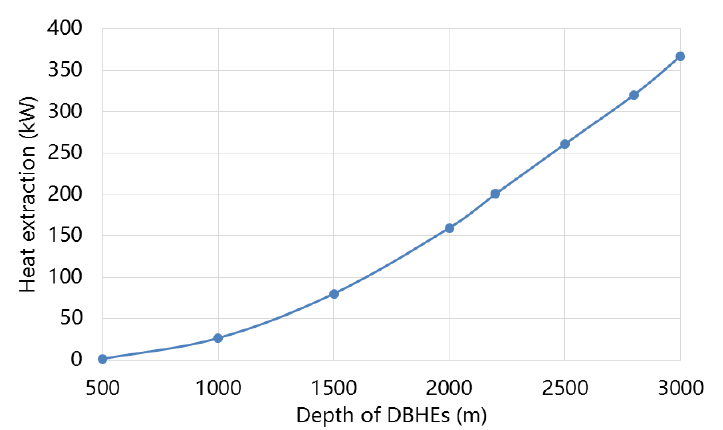
Figure 24. Effect of DBHEs depth on the heat